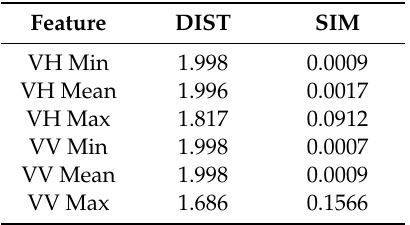
Table 1. Results of the distance (DIST) and similarity (SIM) metrics of classes “water” and “agro-forest” for the investigated time series features minimum (MIN), maximum (MAX), mean (MEAN) and for both polarization channels (VV / VH) (see Figure 6). The two metrics quantify the separation between the frequency distributions of both classes. Higher values in DIST and lower values in SIM point to a better separation offered by the feature under observation.